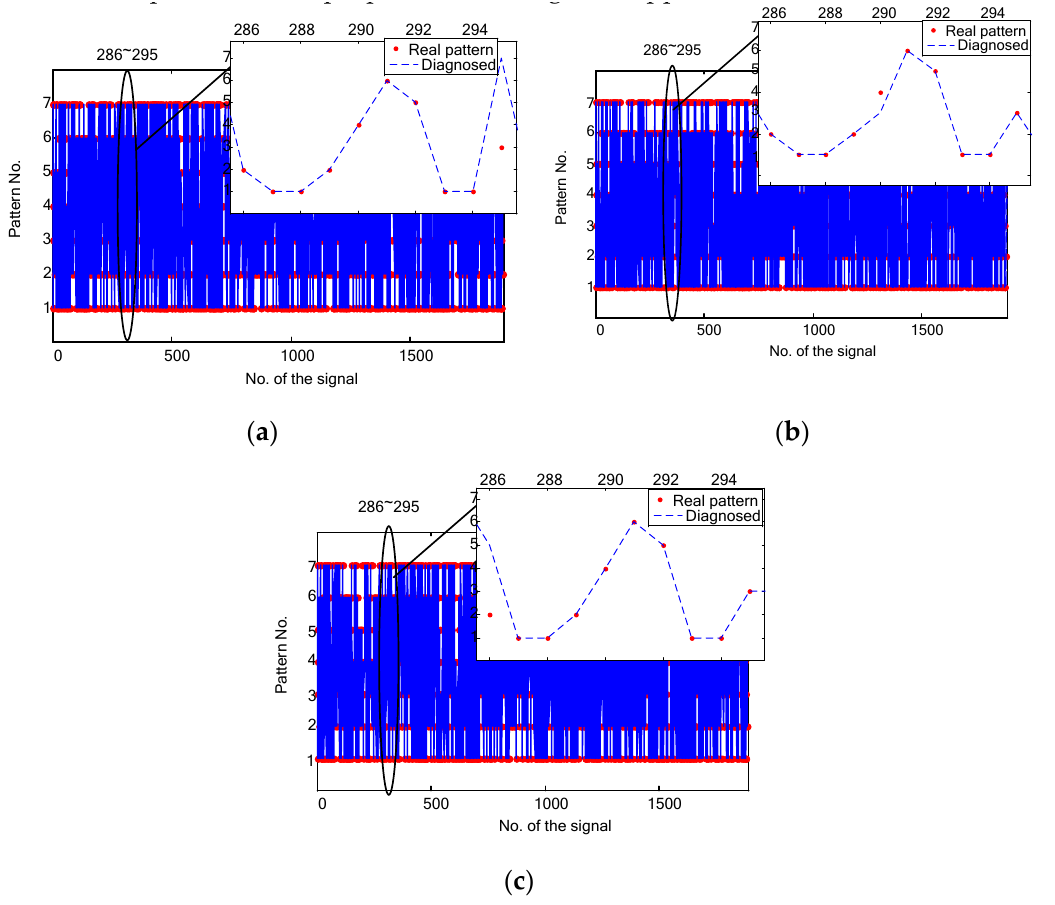
Figure 11. Bearing fault diagnosis results in different domains: ( a ) the time domain; ( b ) the frequency domain; and ( c ) the time-frequency domain.